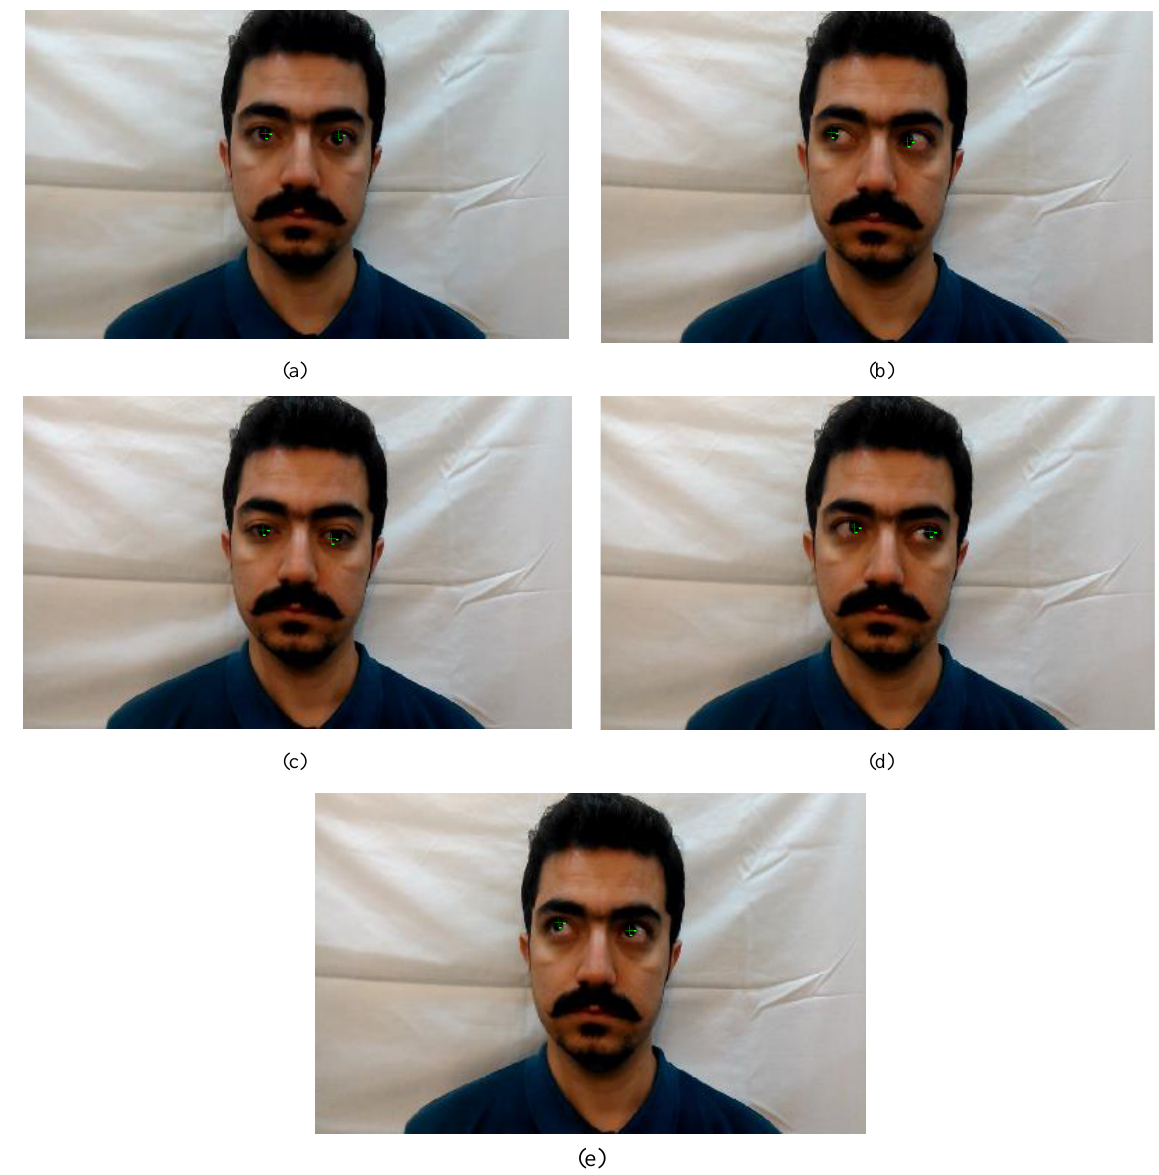
Figure 6. The results of eye tracking in the first scenario: a) frame 1; b) frame 50; c) frame 100; d) frame 150; c) frame 200